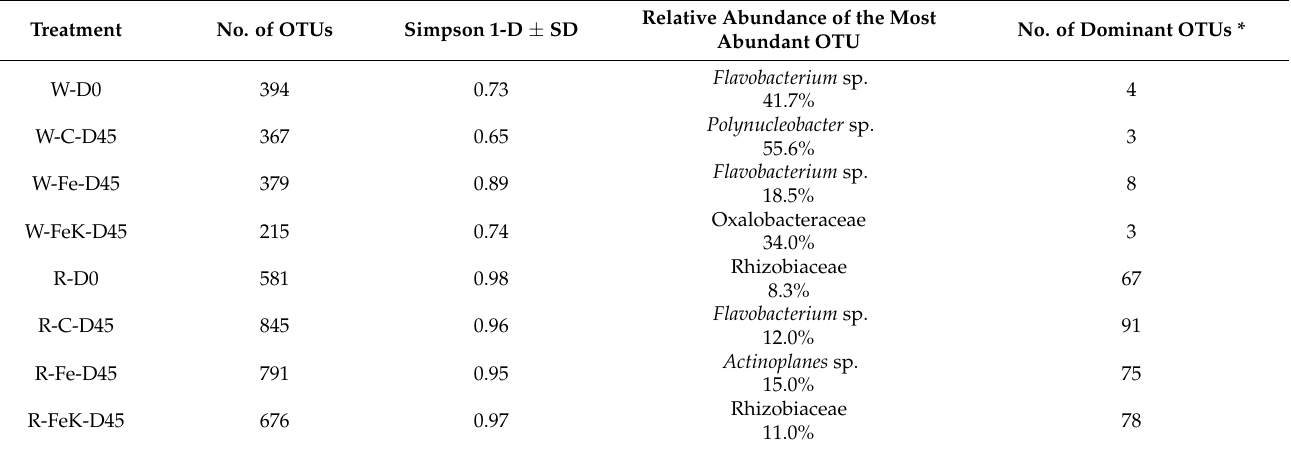
Table 6. Alpha diversity data of water and root bacterial communities. W: water; R: root; C; control; Fe: iron; K: potassium; D0: the first sampling just before the commencement of the experiment; D45: the second sampling at the 45th day of the